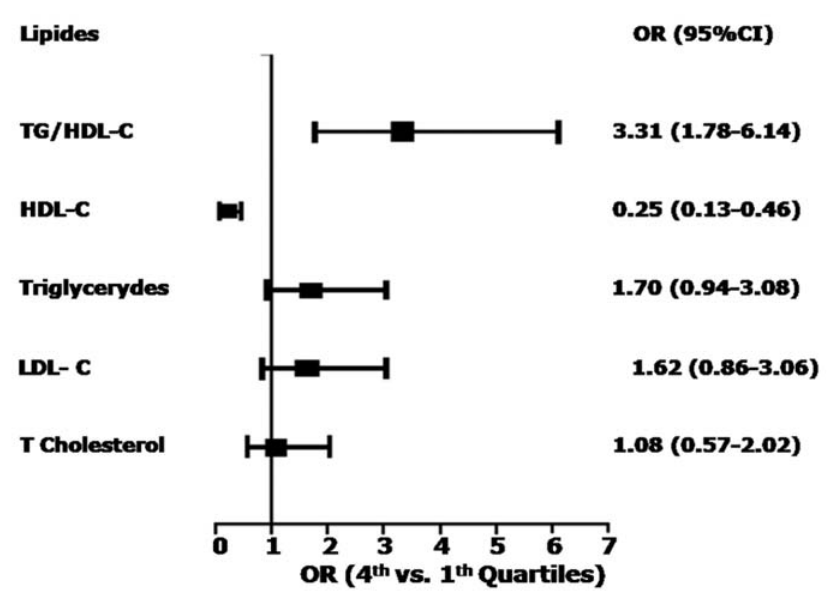
Figure 1 - Odds ratios between fourth and first quartiles of lipid variables for extensive coronary disease (Friesinger index >4)